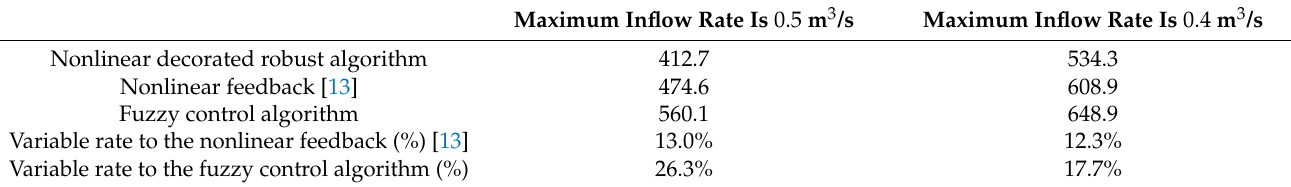
Table 1. Comparison of the Closed Loop Performance